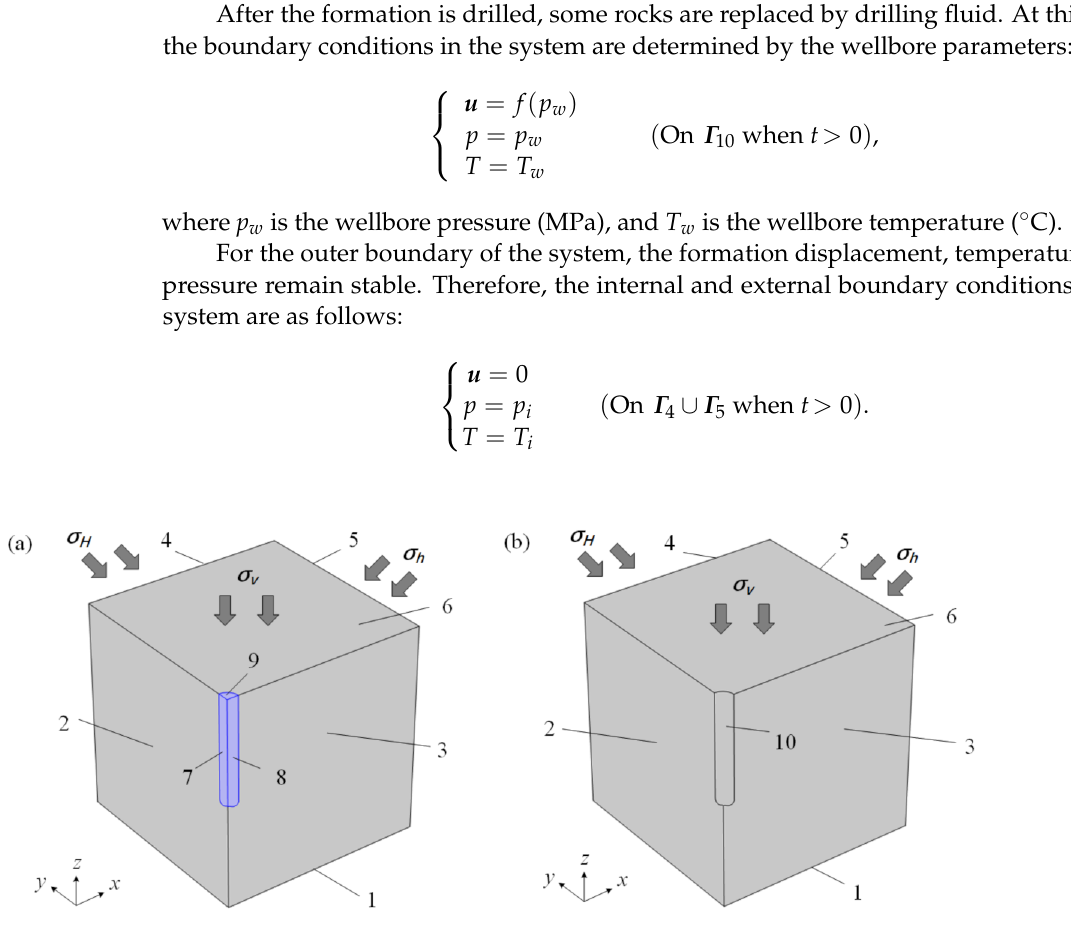
Figure 1. Geometric models of the formation before and after the drilling of the wellbore. ( a ) Before drilling; ( b ) After